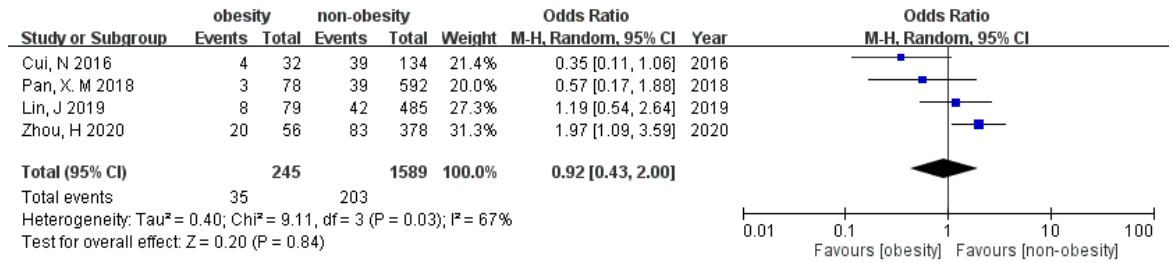
Figure 7. Forest plot of the association between preterm birth and obesity in women with PCOS.